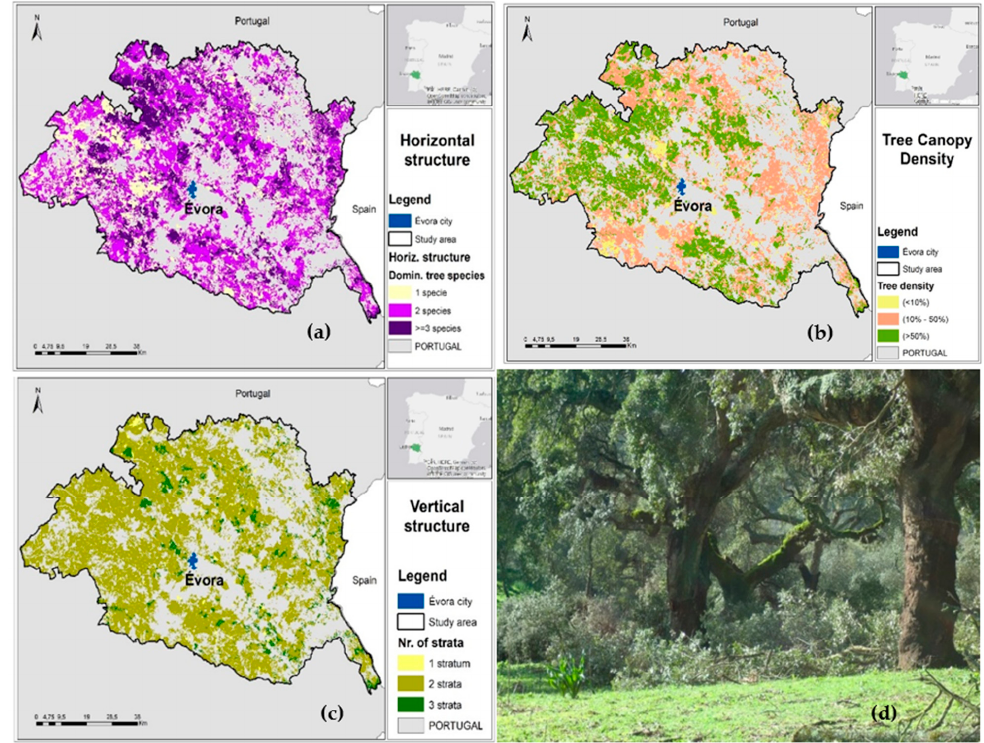
Figure 2. Horizontal and vertical vegetation structure; Tree cover/canopy density (author of maps ( a ), ( b ) and ( c ) and photo ( d ): T. Batista).